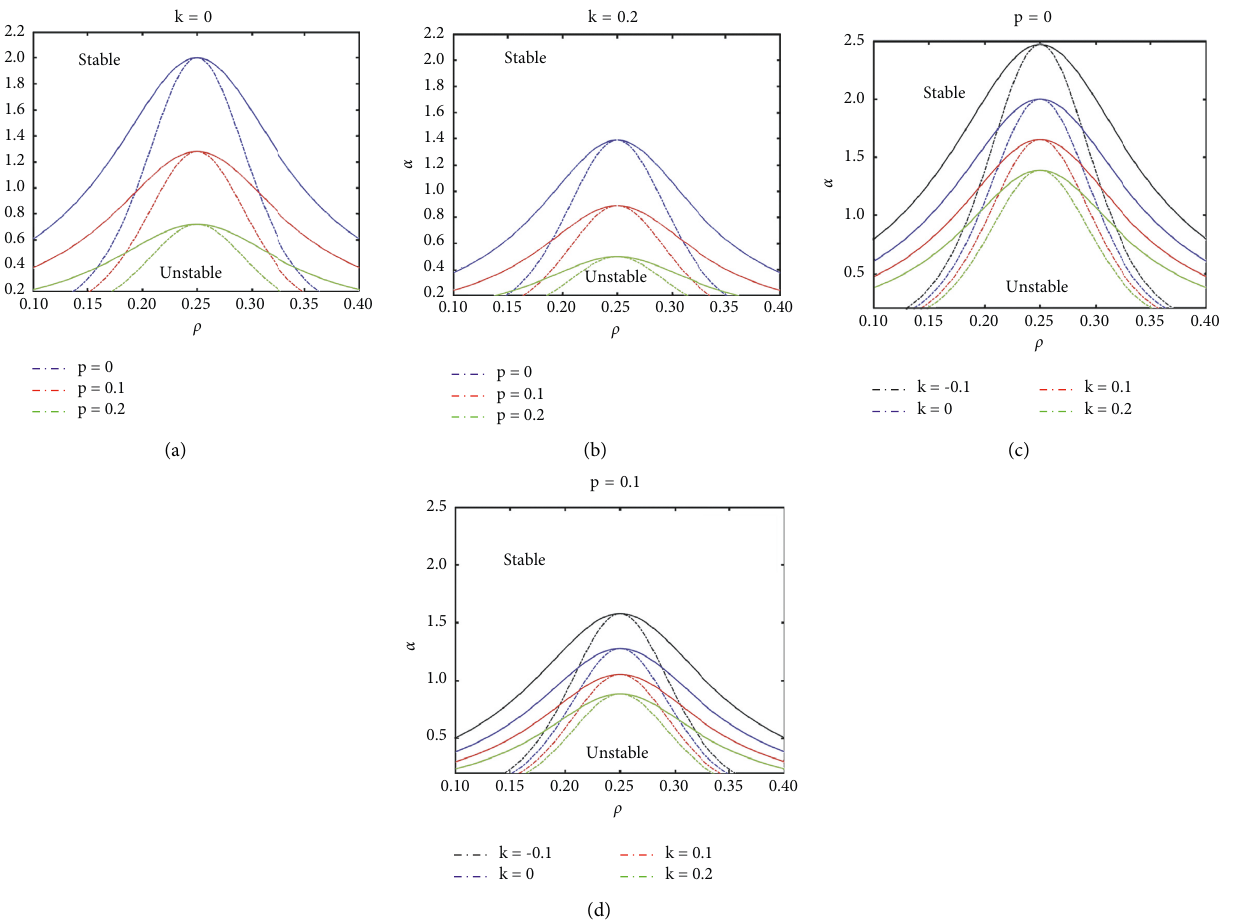
Figure 1: Phase diagram in parameter space ( ρ ,a ) . (a) k � 0. (b) k � 0.2. (c) p � 0. (d) p �